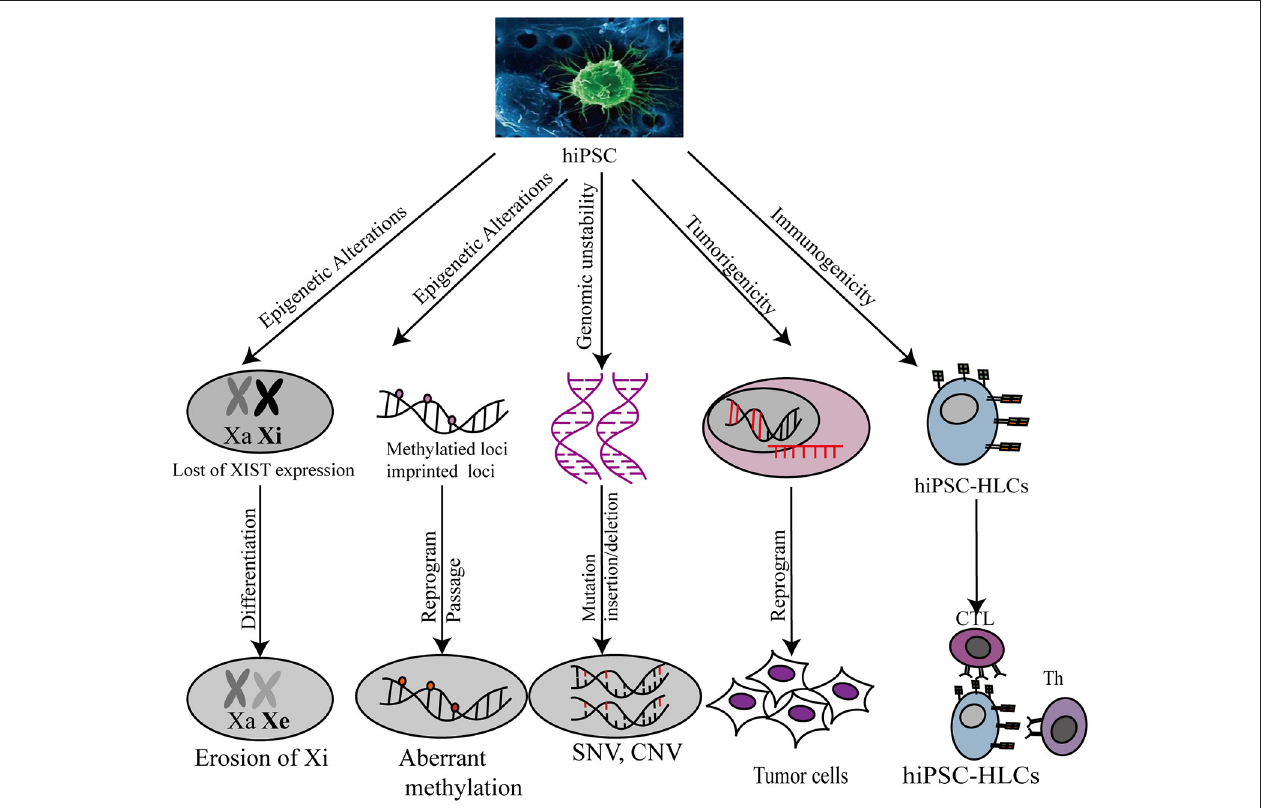
FIGURE 3 | Safety evaluation of hiPSC-HLC in various applications. Xa, X chromosome activity; Xi, X chromosome inactivity; XIST, X-inactive specific transcripts; CNV, copy number variation; SNP, single nucleotide